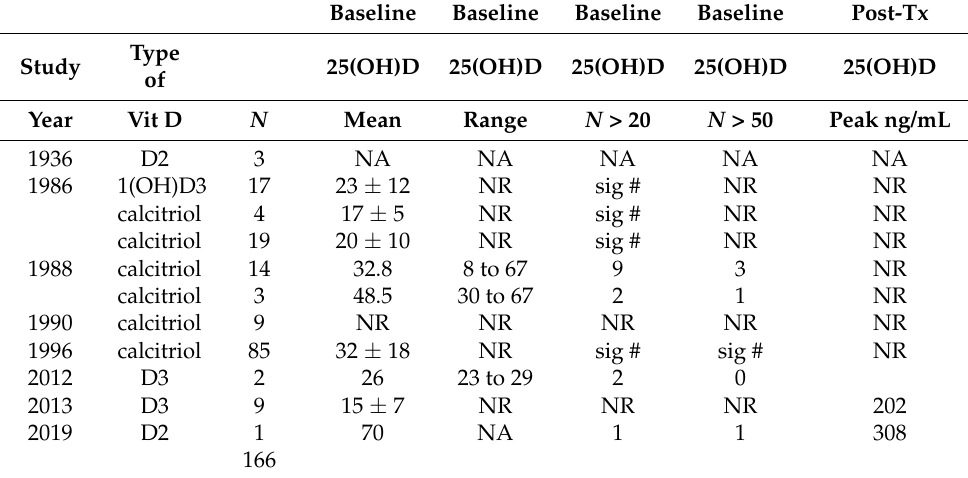
Table 2. Baseline mean serum 25(OH)D concentrations, range at baseline, number greater than 20 ng/mL at baseline, number greater than 50 ng/mL at baseline, and peak serum 25(OH)D concen- trations post-treatment in the vitamin D clinical trials and case reports reviewed. Baseline Baseline Baseline Baseline